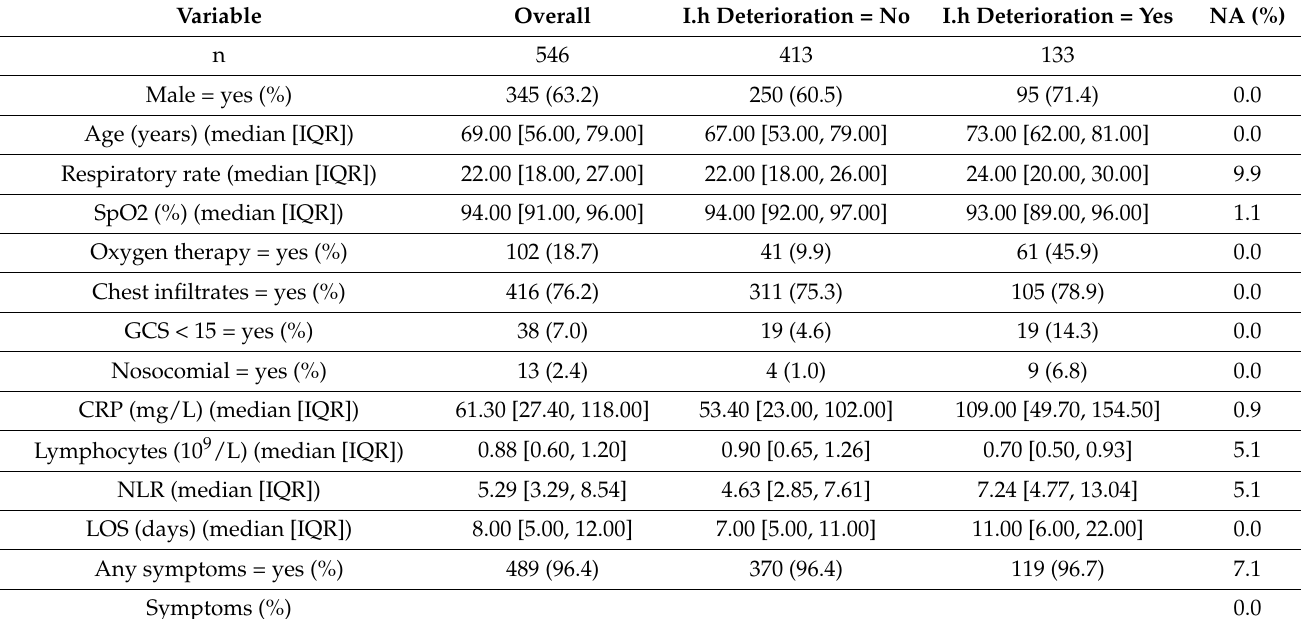
Table 1. Clinical and demographic characteristics of modified 4C Deterioration Model validation cohort.